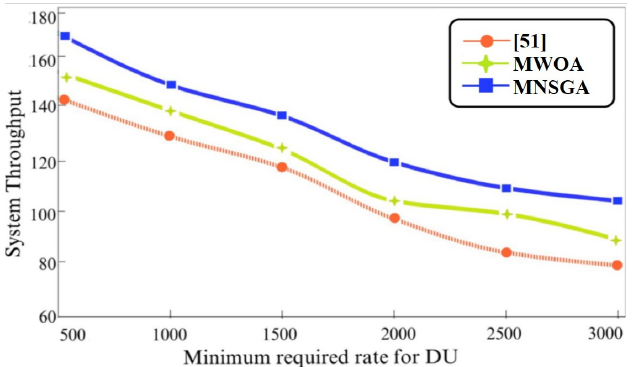
Figure 13. Throughputs for minimum distance between D2D pairs for DU s.